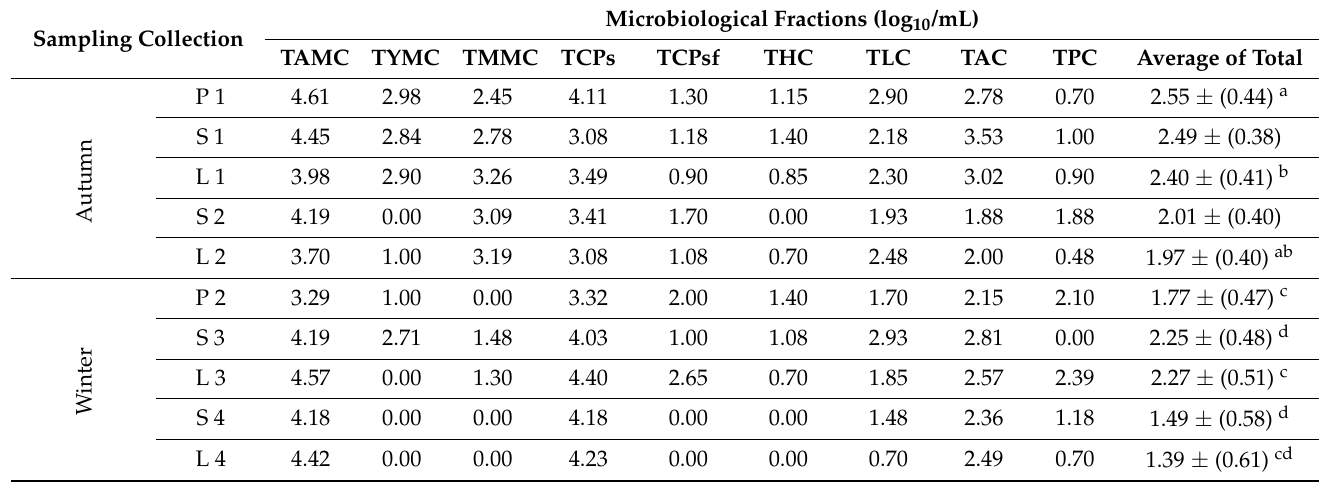
Table 3. Quantitative diversity of microorganisms isolated from water